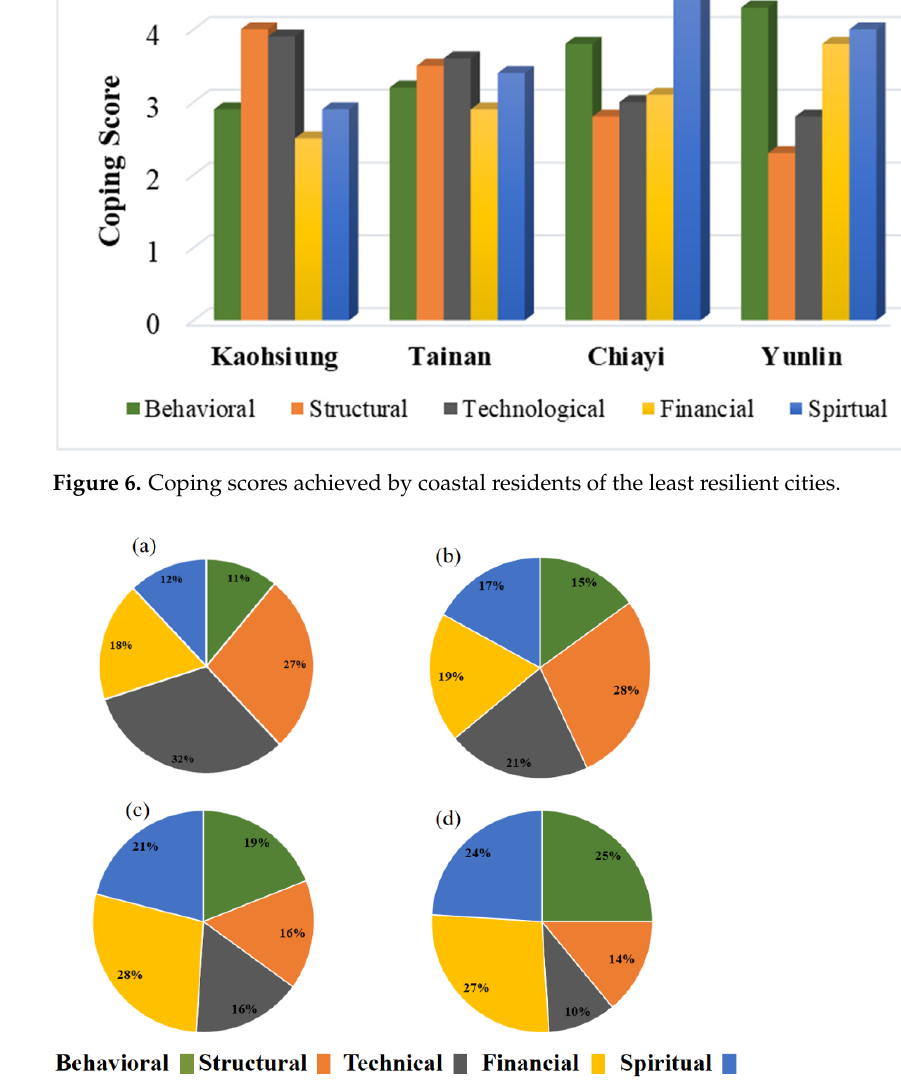
Kaohsiung, ( b ) Tainan, ( c ) Chiayi, and ( d ) Yunlin to deal with extreme weather events.